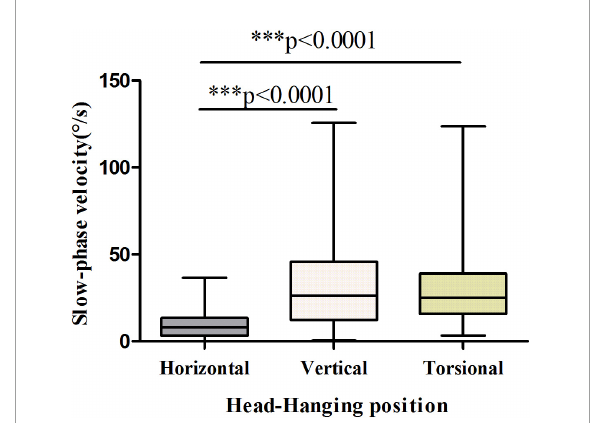
FIGURE3 Slow-phase velocity of nystagmus in the head-hanging position of patients with PSC-can. The slow-phase velocity of nystagmus differed significantly between the horizontal and vertical components ( p < 0.0001), horizontal and torsional components ( p < 0.0001). ∗ p < 0.05, ∗∗ p < 0.01, and ∗∗∗ p < 0.001, compared with respective